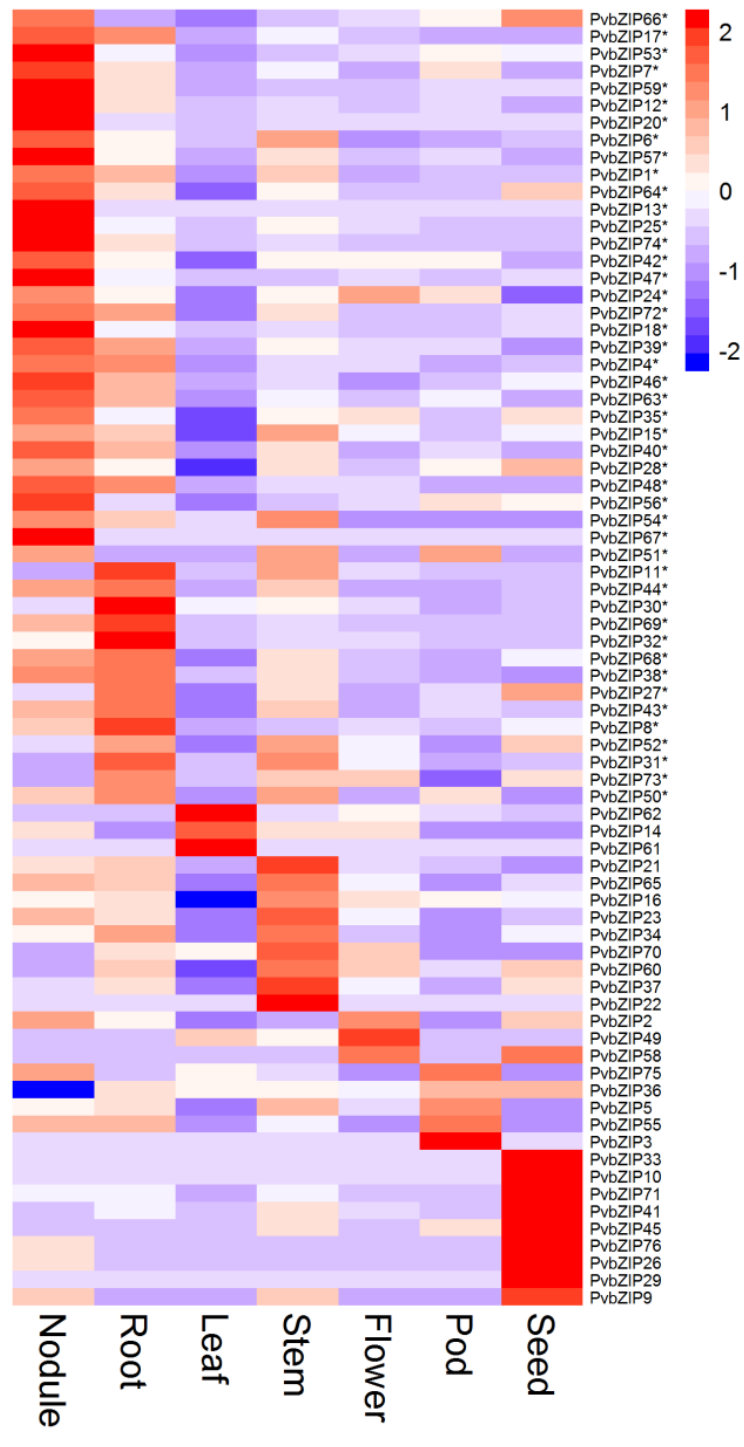
Figure 1. Heatmap of the of P. vulgaris bZIP TF genes that are expressed in different plant tissues. Gene IDs are from www.phytozome.net/commonbean.php. Genes with highest expression in nodule or root are indicated with asterisks. Expression values were extracted from Pv _GEA. Expression patterns (as Z-scores) are indicated in a color scale where red indicates high expression and blue indicates low expression.